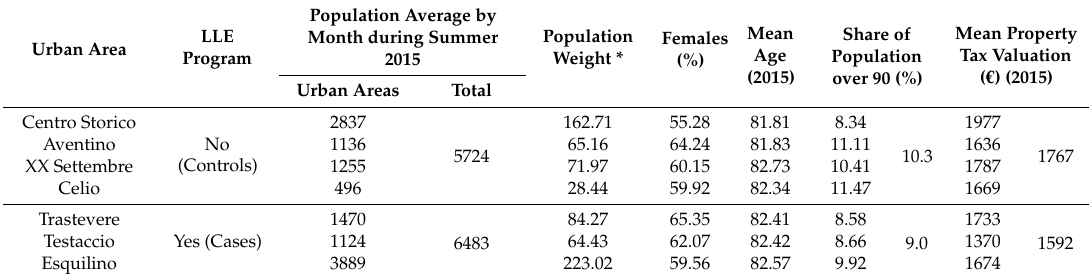
Table 1. Baseline